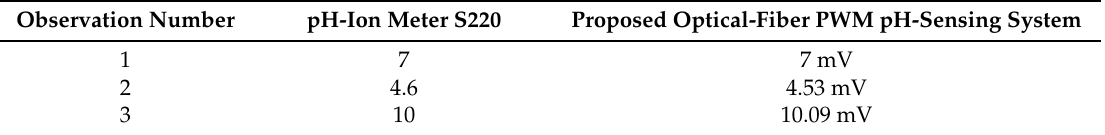
Table 4. pH measurement data using the commercially available pH-Ion meter S220 and the proposed optical-fiber PWM pH-sensing system under different pH of the unknown buffer